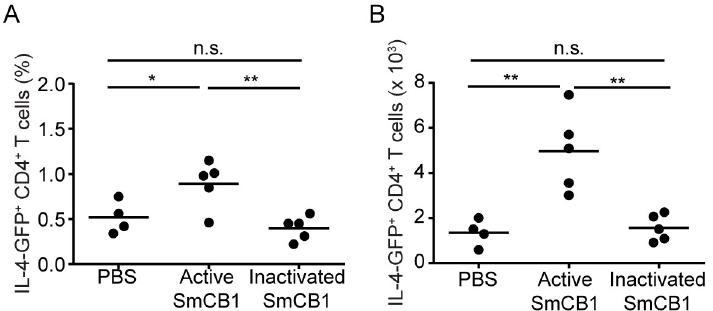
Fig 2. SmCB1 proteolytic activity induces IL-4 expression in CD4 + T cells. 4get IL-4 reporter mice were immunized subcutaneously in the footpad with either PBS, active SmCB1, or inactivated SmCB1 on day 0, 14 and 21. On day 22, the draining popliteal and inguinal nodes were removed and the frequency (A) and total number (B) of IL-4-GFP + CD4 + T cells were determined by flow cytometry. n.s., P > 0.05; � , P < 0.05; �� , P < 0.01.